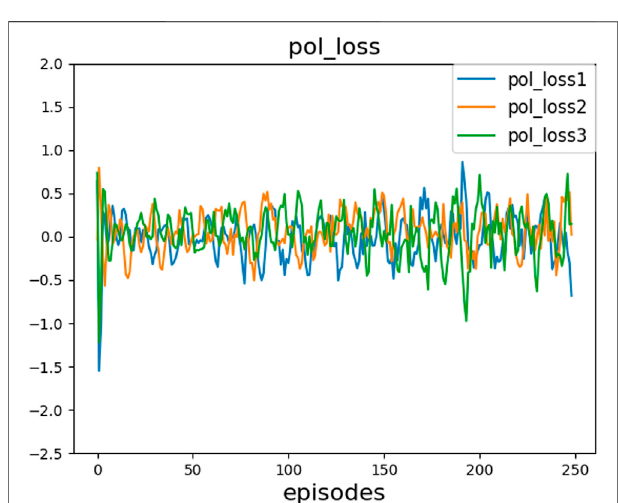
FIGURE 6 | Strategy loss function curve.